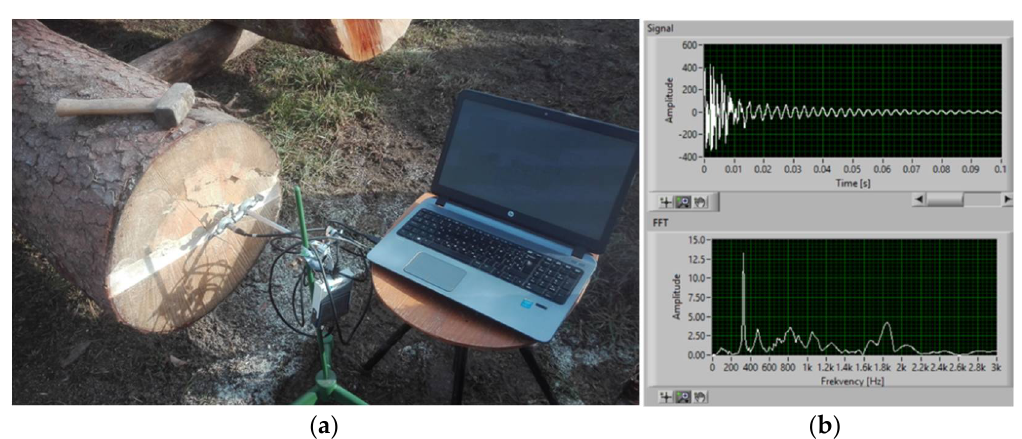
Figure 3. Acquisition of the sound signal at longitudinal vibration of logs ( a ) and recorded sound scheme ( b ), using least-squares regression analysis ( α —temporal damping), whereby the value of the damping coefficient, i.e., loss tangent (tan δ ) was determined (Equation (2)).